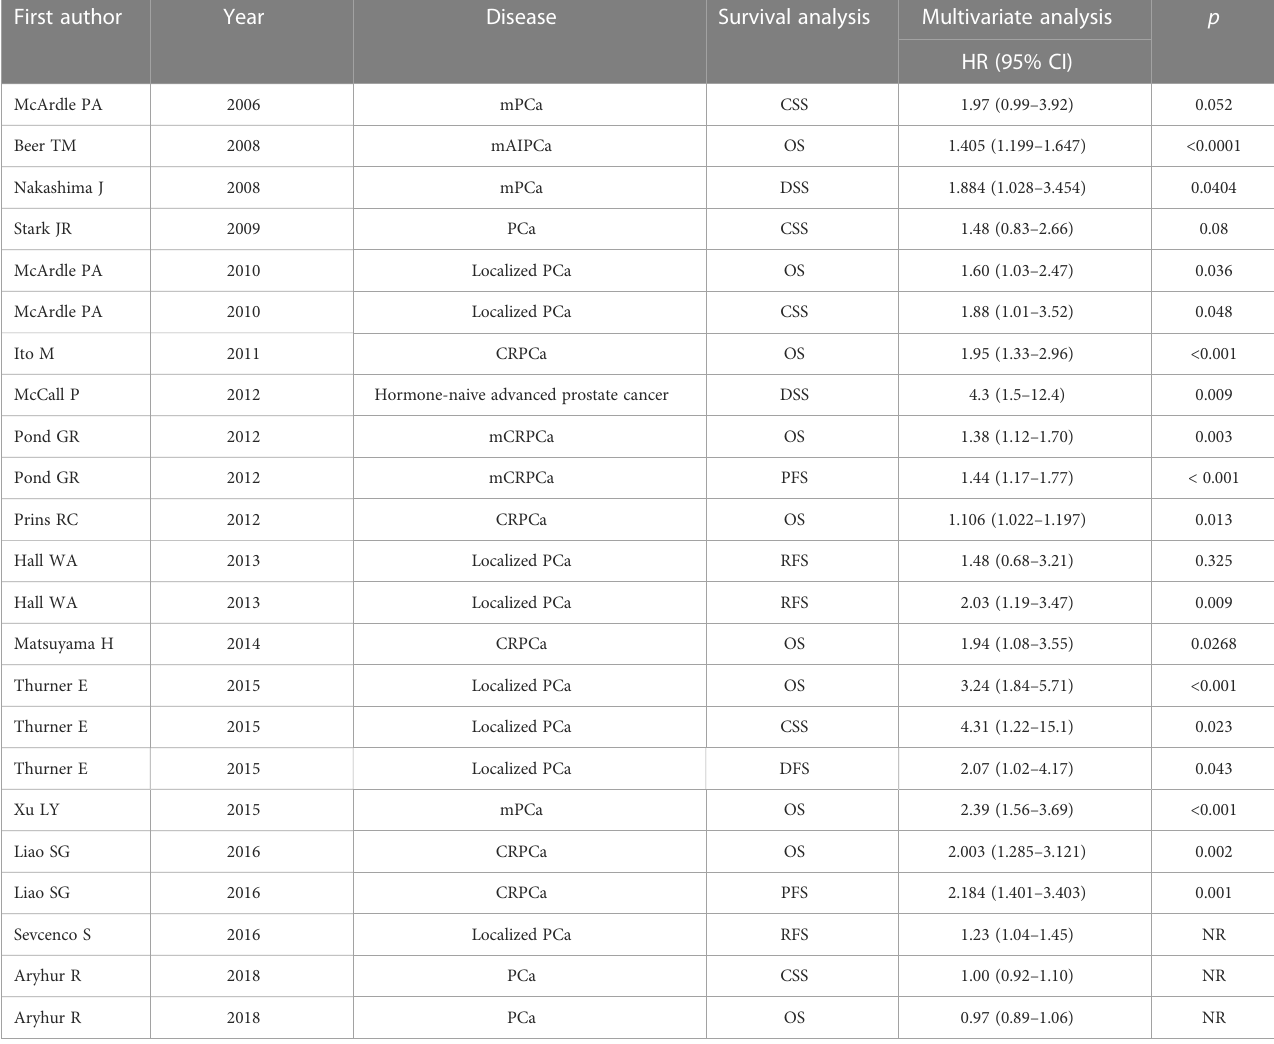
TABLE 2 Main data of studies included in this